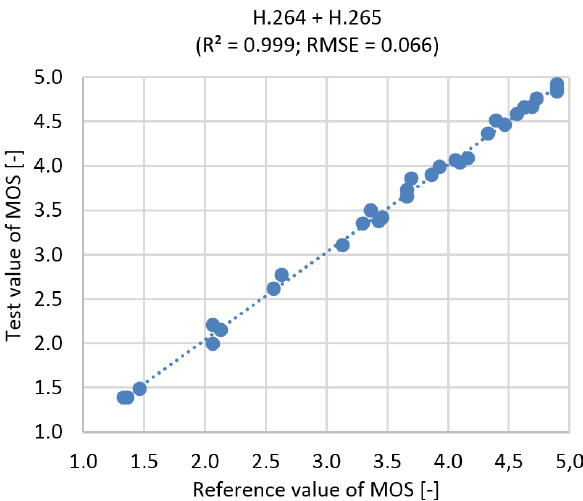
Figure 19. Correlation diagram for MOS prediction, Ultra HD, H.264 +